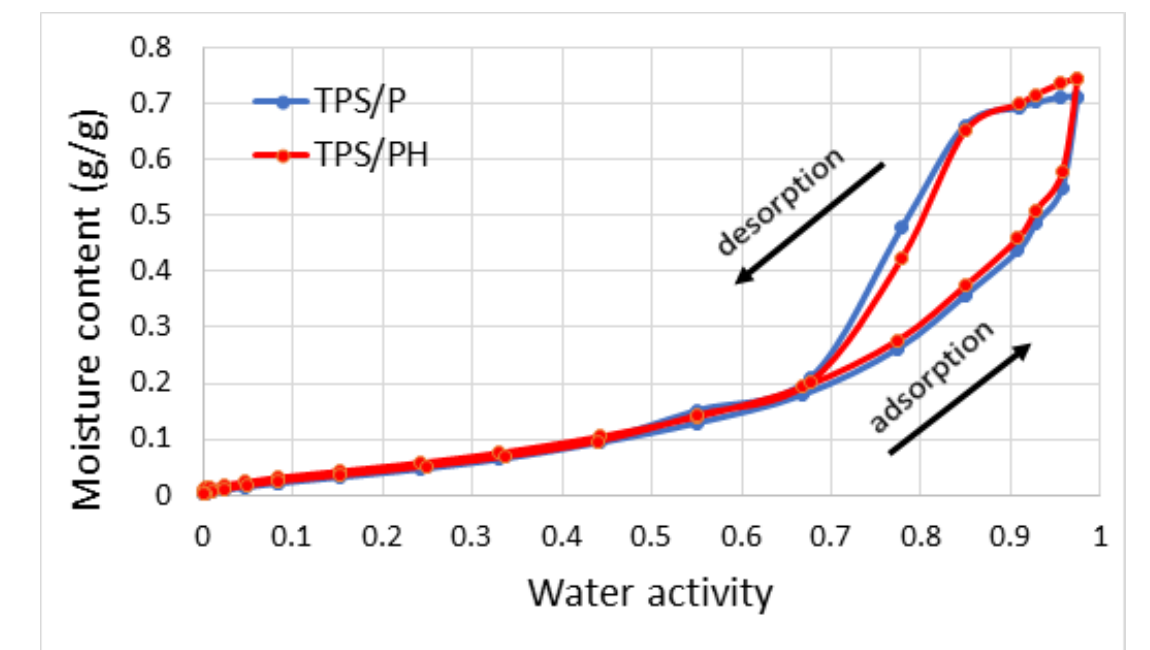
Figure 6. Water sorption/desorption isotherms of the analyzed thermoplastic starch films.